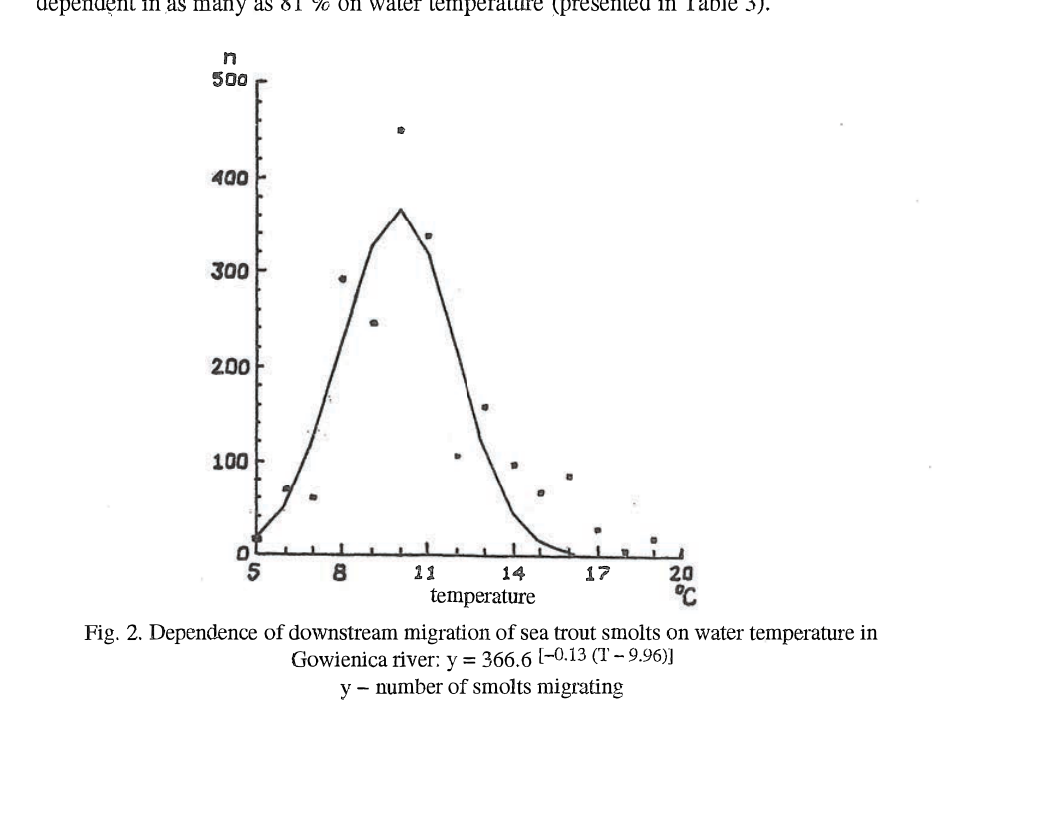
2. Dependence of downstream migration of sea trout smolts on water temperature in Gowienica river; y = 366.6 [-0.13 (T- 9.96)] y -number of smo1ts